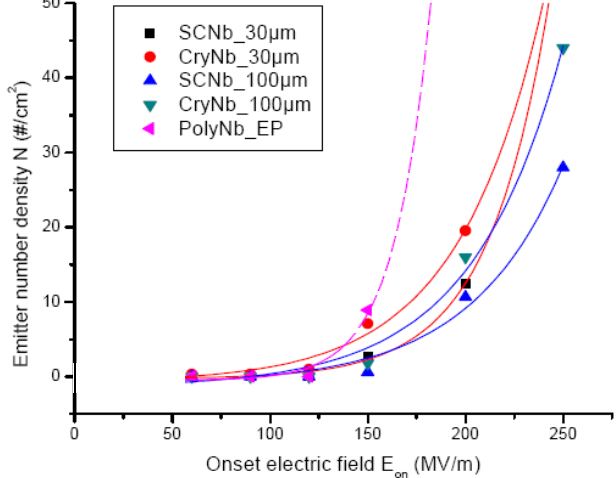
FIG. 3. (Color) Emitter number density vs applied electric field for different material removal. (Exponential fit lines: Red for 30 (cid:1) m BCP, blue for 100 (cid:1) m BCP, and magenta for EP poly- crystalline Nb